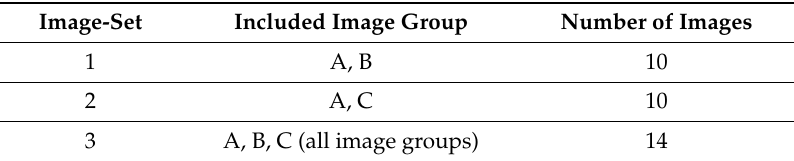
Table 16. Image-set configuration for additional experiments.